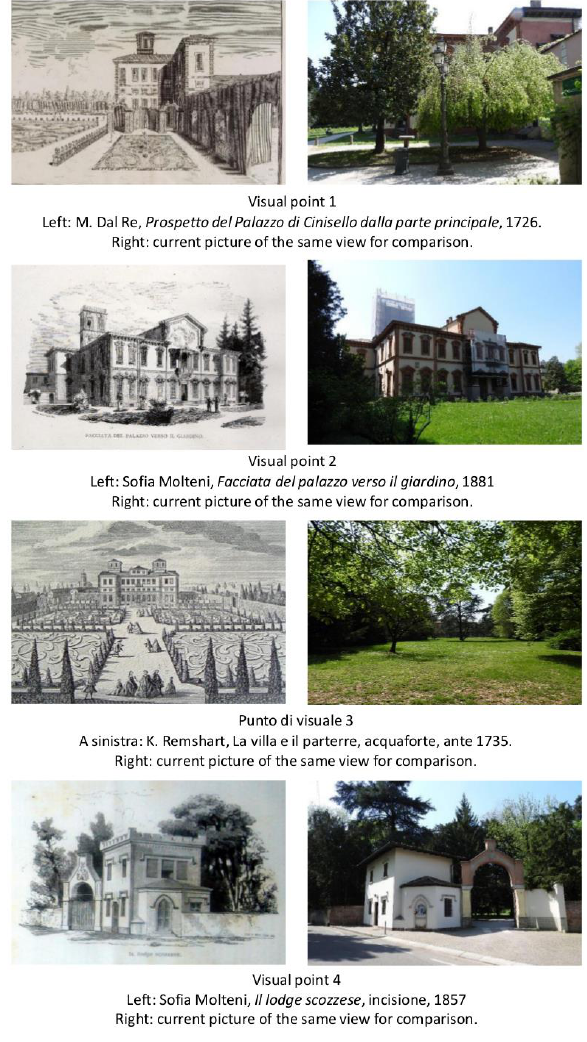
Figure 2. Comparison between historical images and current pictures of the same views throughout Villa Ghirlanda Silva historic public garden in Cinisello Balsamo (Milan